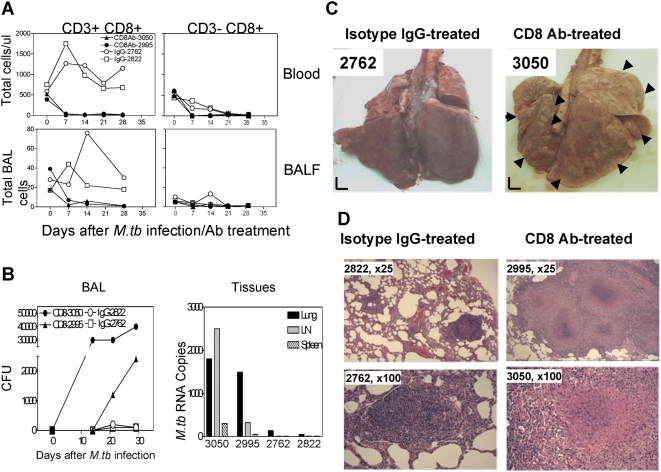
Depletion of CD8 lymphocytes in macaques immunized by previous M. tuberculosis infection resulted in a loss of immune control of tuberculosis following re-infection.(A) Anti-CD8 Ab treatment of the M. tuberculosis-immunized macaques resulted in profound depletion of CD8 lymphocytes in M. tuberculosis re-infection. Shown are absolute levels of blood CD8 cells (/ul) and BAL fluid CD8 cells (×50,000). (B) Depletion of CD8 lymphocytes in the M. tuberculosis-immunized macaques led to higher levels of bacilli in BAL fluids and increased M. tuberculosis RNA in tissues following M. tuberculosis re-infection by aerosol. Numbers of bacilli are shown as CFU counts in 10 ml of BAL fluid; M. tuberculosis RNA was determined as Ag85B RNA copy numbers in 10 mg of tissue [6],[29],[36]. (C) The CD8 Ab-treated macaques with CD8 depletion developed severe forms of tuberculosis after M. tuberculosis re-infection by aerosol. Macaque ID are indicated for CD8 Ab-treated (right) and isotype control IgG-treated (left) macaques. Shown are the lung surface images of two representative macaques (partially cut in the lung of macaque 2762). Note that the CD8 Ab-treated macaques exhibited pale-colored lungs with dissemination of >0.5 cm coalescing or caseating granulomas or tubercle nodules (the lesion-containing areas are pointed out by large arrows on surface view from 3050) and apparent caseation necrosis. The control macaques displayed no or few small non-caseating granulomas as indicated by small arrows in the lungs. When >0.5 cm coalescing or caseating tubercle nodules both lungs were scored using the scoring system as described in Methods and [41] for the individual macaques, the pathology scores (mean±SD = 72±24) of the CD8-depleted macaques were significantly worse than those (mean±SD = 6±2) of the control animals (p<0.01, by nonparametric t test). (D) Histology of representative granulomas seen in CD8 Ab-treated (right panel) and isotype control IgG-treated (left panel) macaques. Shown are H&E stained lung sections, with macaque ID and magnification indicated in each slide. Note that granulomas in isotype IgG-treated macaques were small, and highly lymphocytic without apparent necrosis. Granulomas in CD8 Ab-treated macaques were large and less lymphocytic, with necrosis seen in the center as pointed out by arrows.